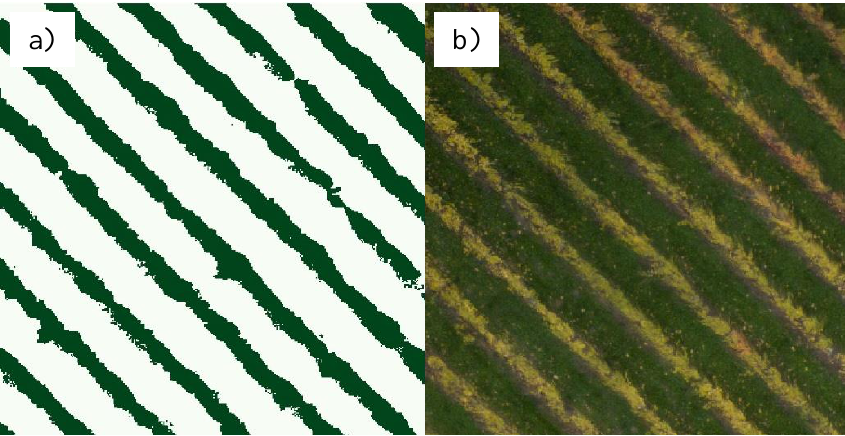
Figure 10 a) pixels of the DDM with a height > 0.5 [m]. b) RGB image of the same zone. The yellow color correspond to the autumn color of the leaves, before